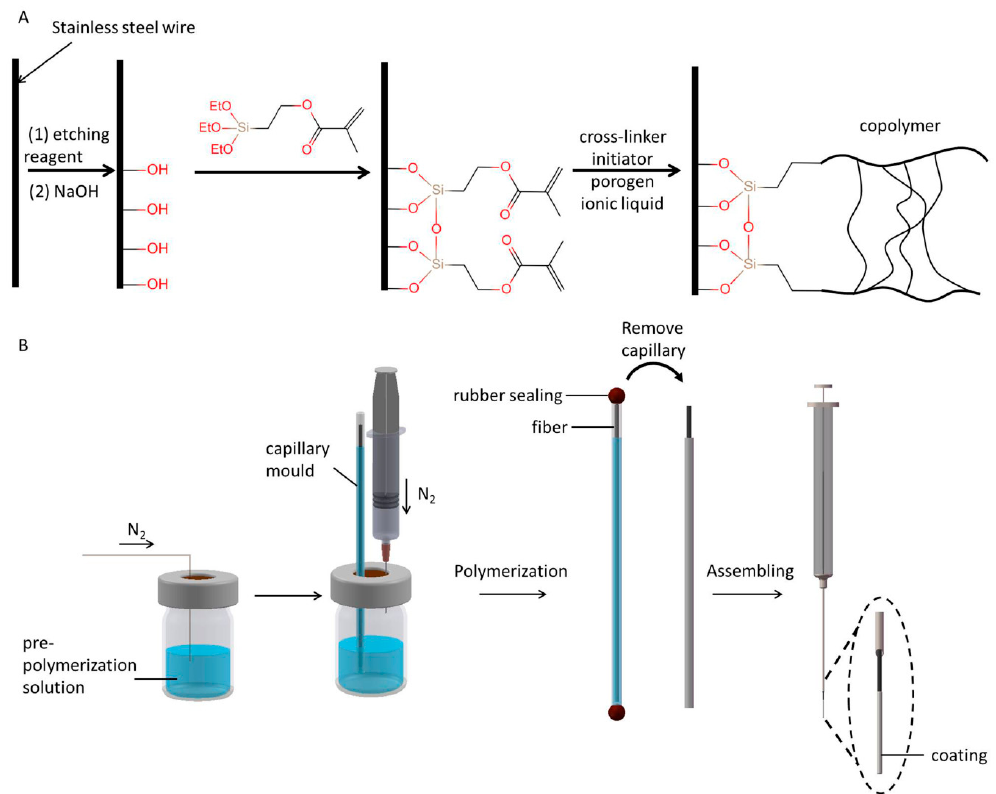
Figure 1. Workflow of the preparation of the copolymer coating: ( A ) Schematic diagram of the pretreatment of SSW and copolymer polymerization; ( B ) schematic diagram of the coating preparation.